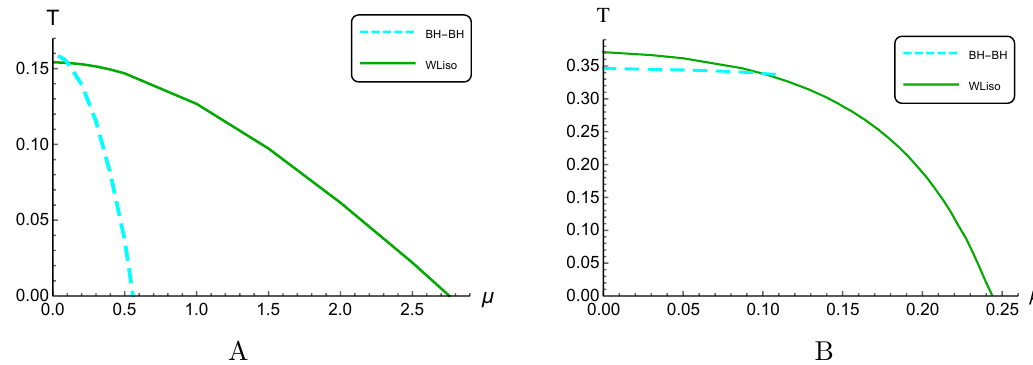
Figure 1 . Holographic QCD phase diagrams for light (A) and heavy (B) quarks in the isotropic case [24, 29]. Here first-order Hawking-Page-like phase transitions (BH-BH) are indicated by dashed lines. Wilson loop (crossover) phase transitions (WLiso) are indicated by solid